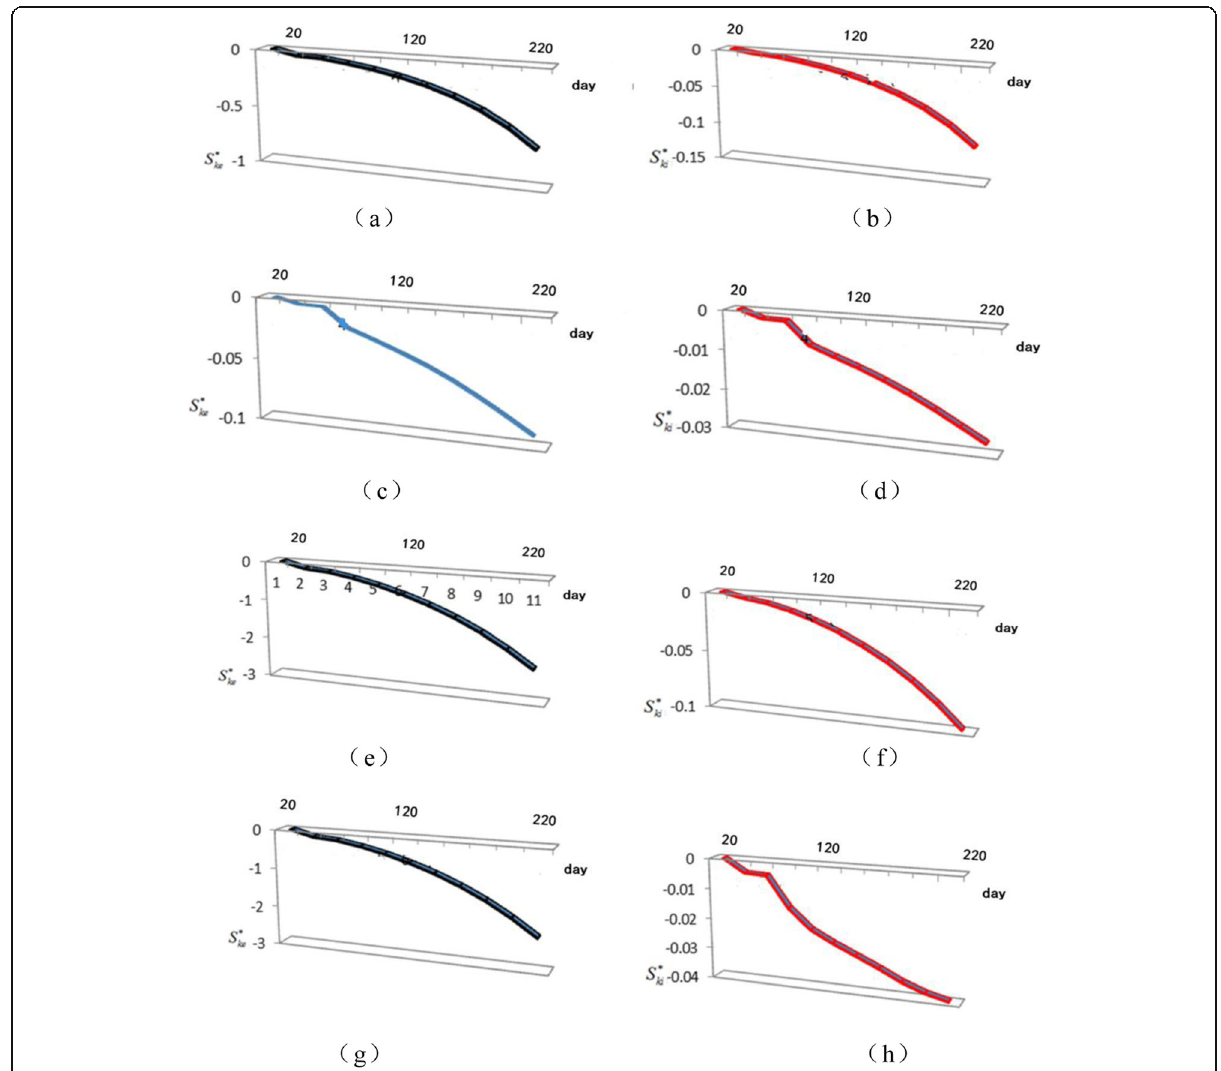
Fig. 14 Curve of elastic and inelastic water release coefficient over time. a Elastic water storage coefficient change curve of experiment site 1. b Inelastic water storage coefficient change curve of experiment site 1. c Elastic water storage coefficient change curve of experiment site 2. d Inelastic water storage coefficient change curve of experiment site 2. e Elastic water storage coefficient change curve of experiment site 3. f Inelastic water storage coefficient change curve of experiment site 3. g Elastic water storage coefficient change curve of experiment site 4. h Inelastic water storage coefficient change curve of experiment site